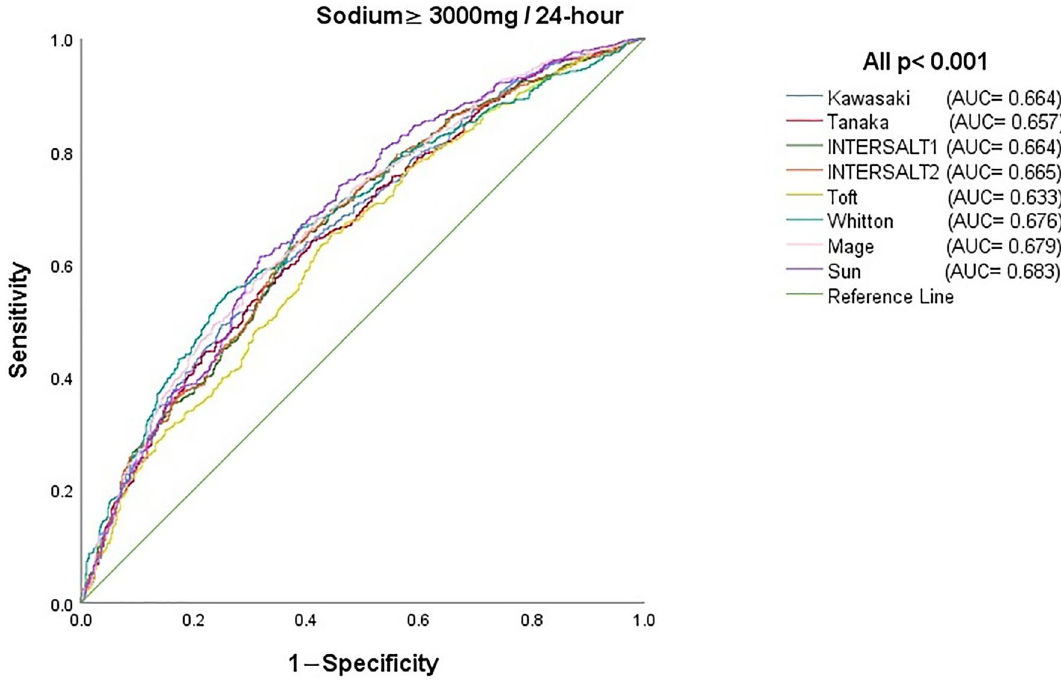
Figure 1. Area under the ROC curve for predicting the 24-h urinary sodium level among individuals whose sodium level was more than 3000 mg/24